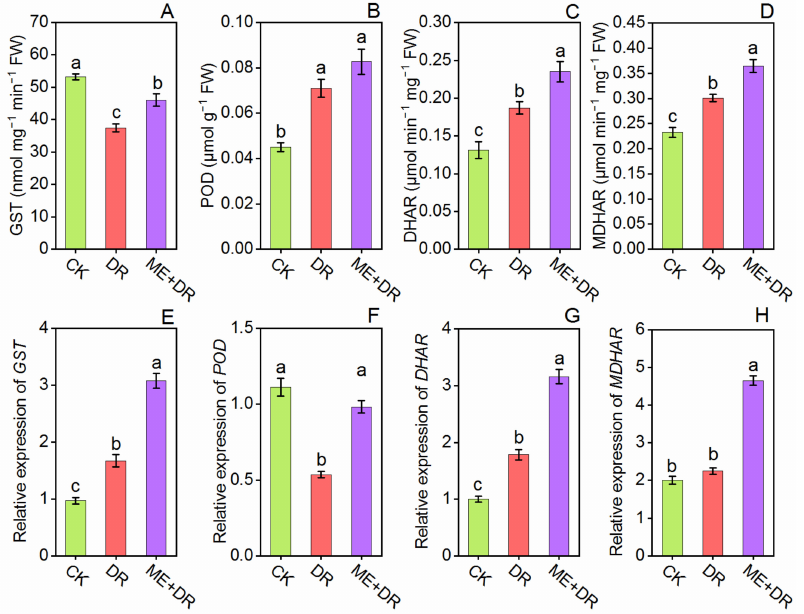
Figure 8. Exogenous supplementation of melatonin promoted antioxidant enzymes [GST ( A ), POD ( B ), DHAR ( C ), MDHAR ( D )] and their encoding genes [ GST ( E ), POD ( F ), DHAR ( G ), MDHAR ( H )] of tomato seedlings under drought stress condition, as shown by leaf’ analysis. Means ± standard error, n = 3, significant difference is exhibited by lowercase letters ( p ≤ 0.05), according to LSD